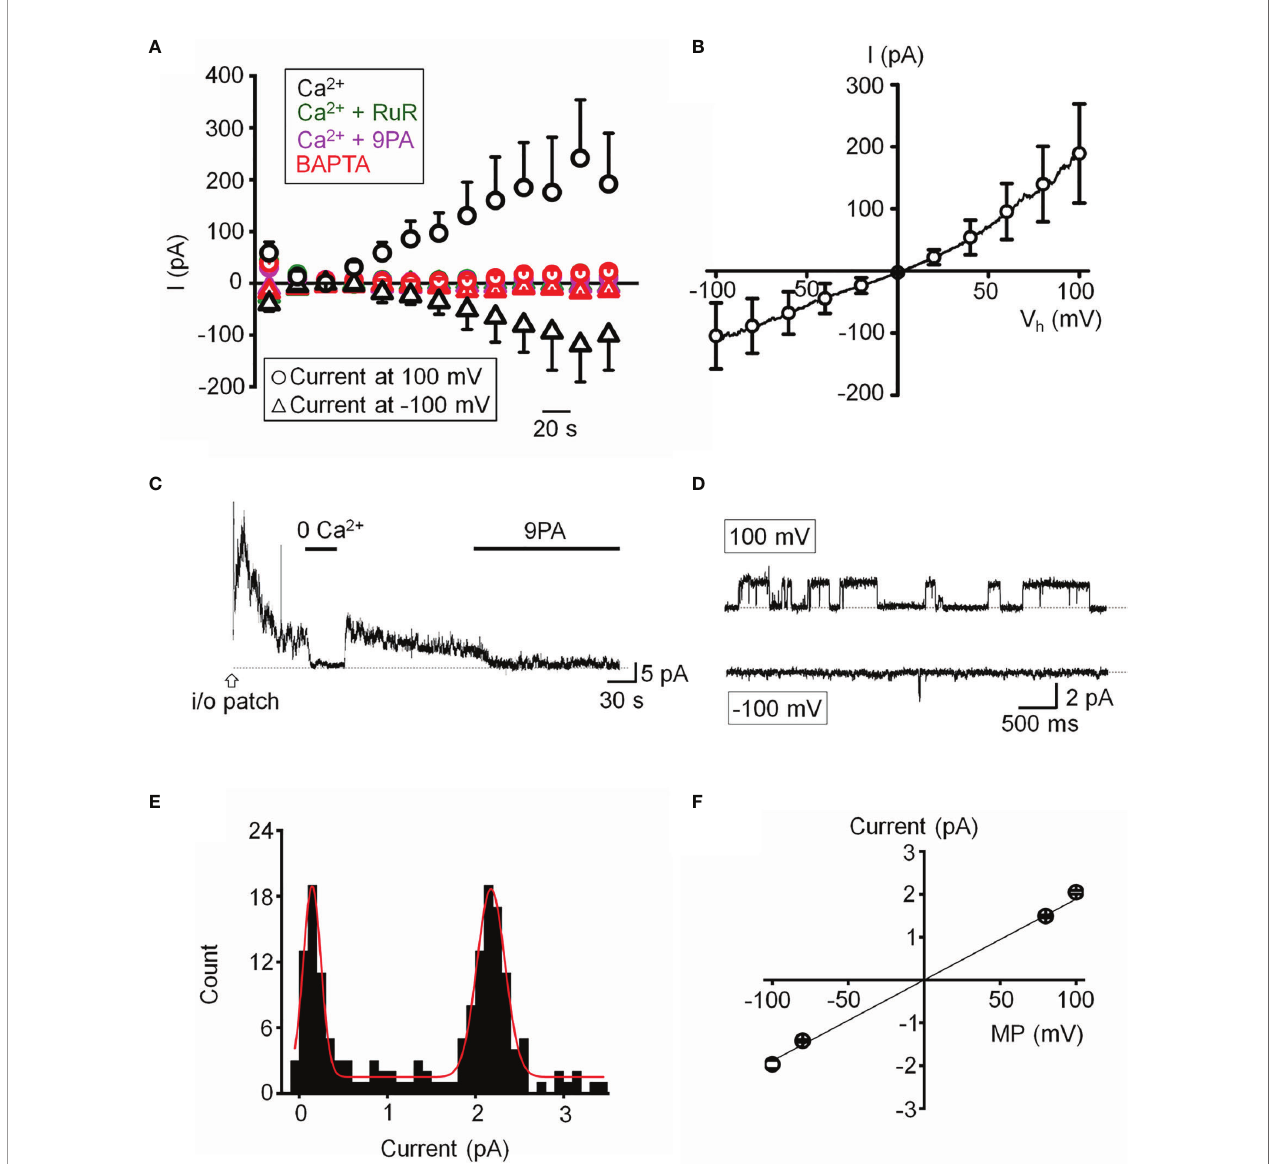
FIGURE 6 | Functional expression of a calcium-activated non-selective cation channels. (A) Time course of the whole-cell current recorded at the holding potentials 100 and -100 mV. The pipette solution contained 10 µM Ca 2+ in the standard saline ( black , n = 5), with addition of Ruthenium Red (RuR; 10 µM ; olive , n = 11), 9-PA (20 µM ; magenta , n = 15) in extracellular solution, or Ca 2+ -free pipette solution ( red , n = 15). (B) Averaged current-voltage relationship of the Ca 2+ activated current in A subtracted by the Ca 2+ -free component (n = 6). (C) Representative trace demonstrating the activity of a Ca 2+ -activated channel in an inside-out patch preparation at +100 mV. (D) Representative traces of single channel activity. (E) Histogram of unitary current amplitude, fi t with Gaussian function (red trace; R-Square = 96.6%). The data were binned at 0.02 pA. (F) Current-voltage relationship of single channel current, n = 6 patches. (A, B, F) show mean ±